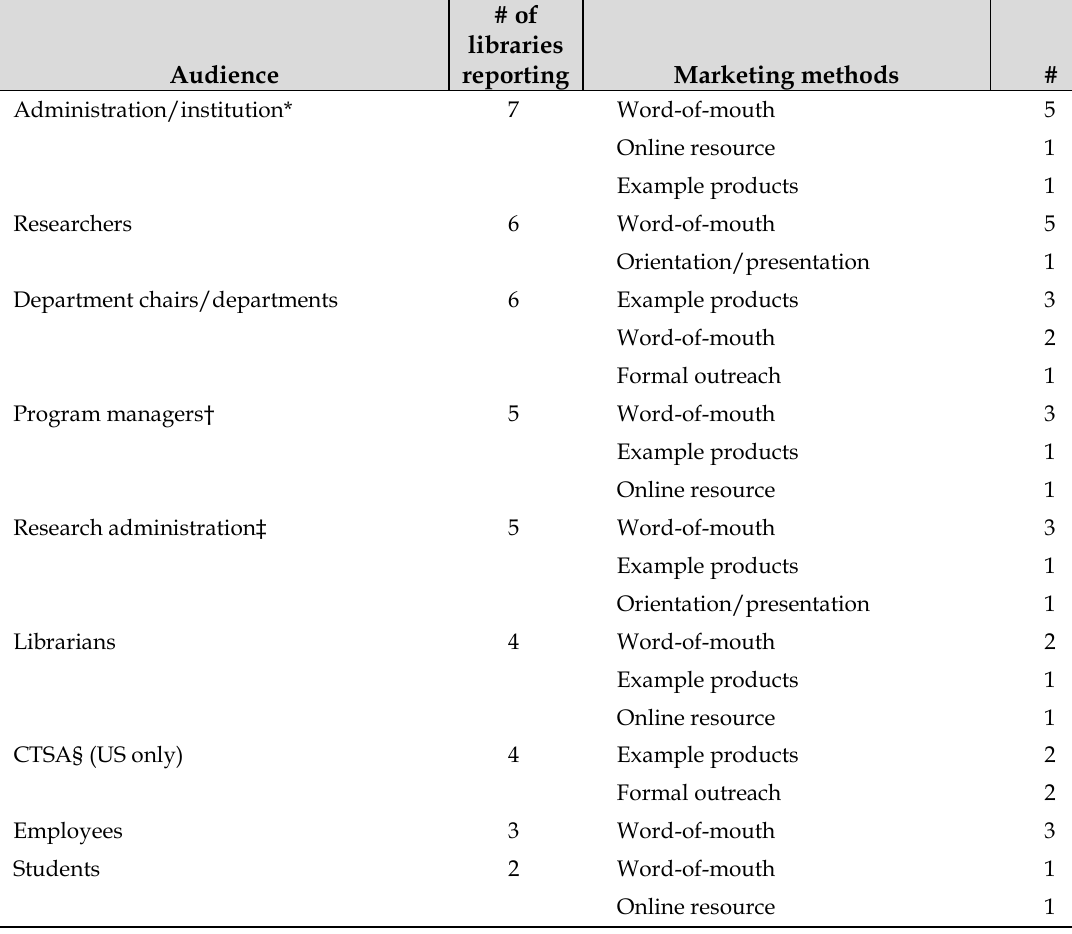
Table 5 Top audiences and approaches for marketing